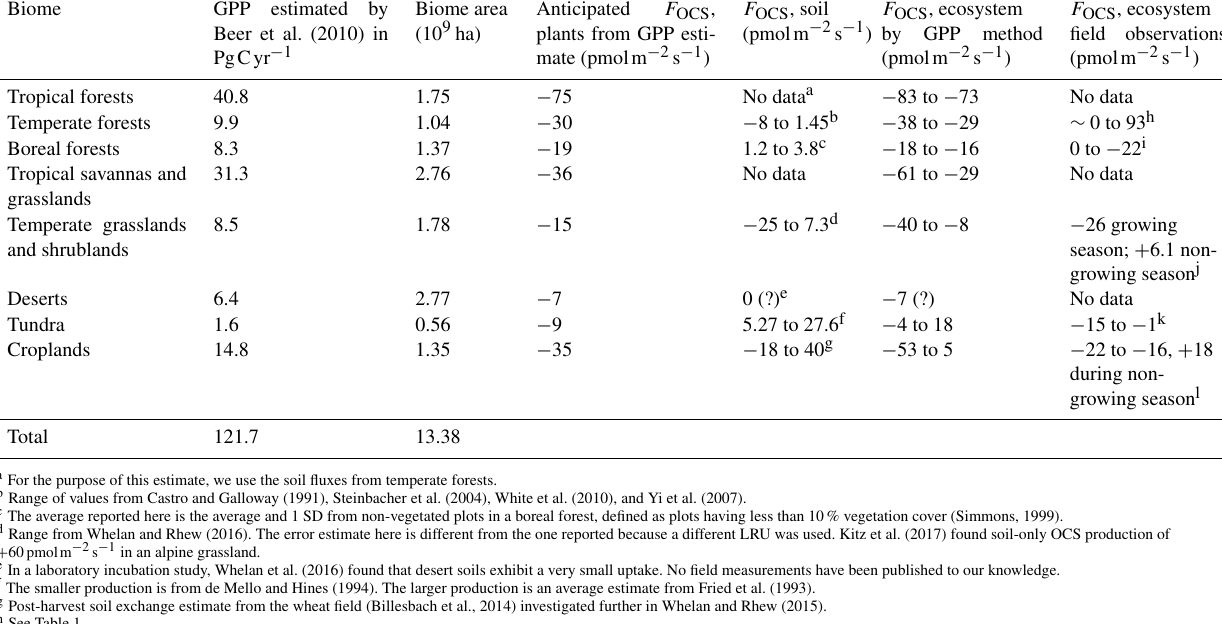
Table 5. GPP and OCS exchange estimates by